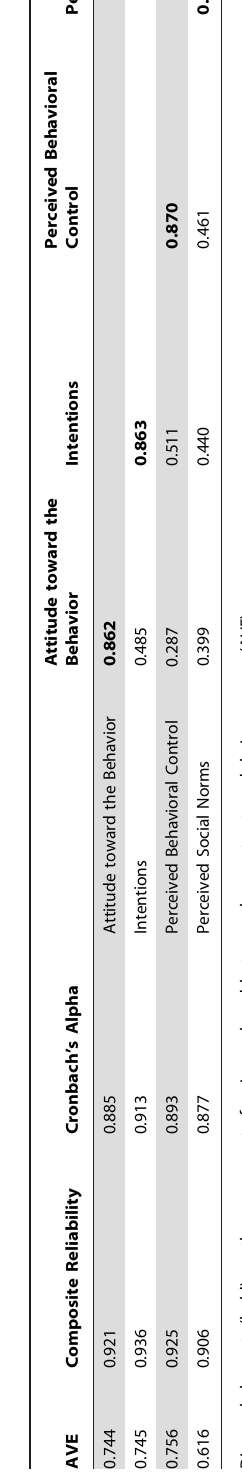
Attitude toward the